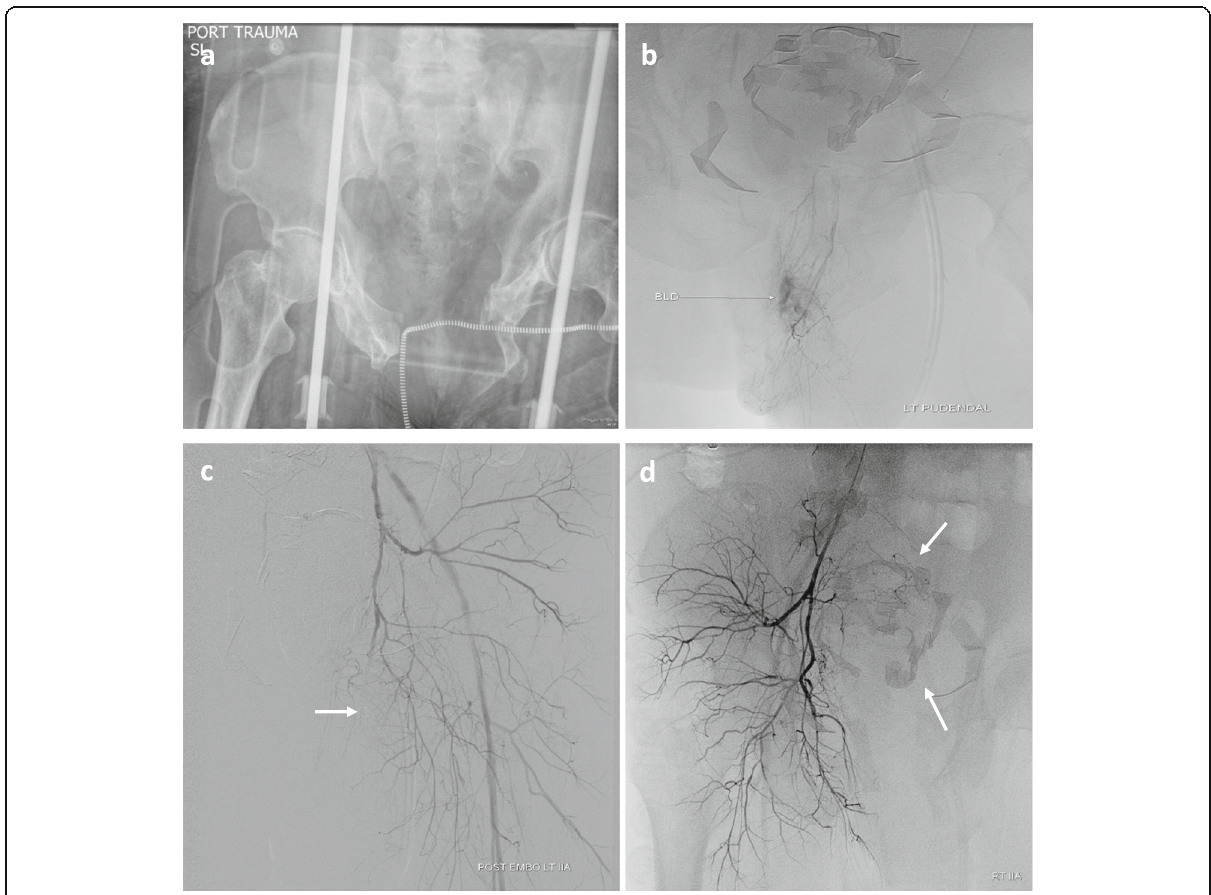
Fig. 1 Patient 1 Initial angioembolization procedure via a trans-radial approach: AP Pelvis radiograph showing open book pelvic fractures ( a ). Superselective left pudendal artery angiogram ( b ). Follow-up left internal iliac angiogram showing coil occluded (arrow) left pudendal artery, reflux into the external iliac artery, and no other signs of hemorrhage in the left hemi-pelvis ( c ). Negative right internal iliac angiogram also showing reflux into the external iliac artery. Note lap sponges in the mid pelvis (arrrows) ( d